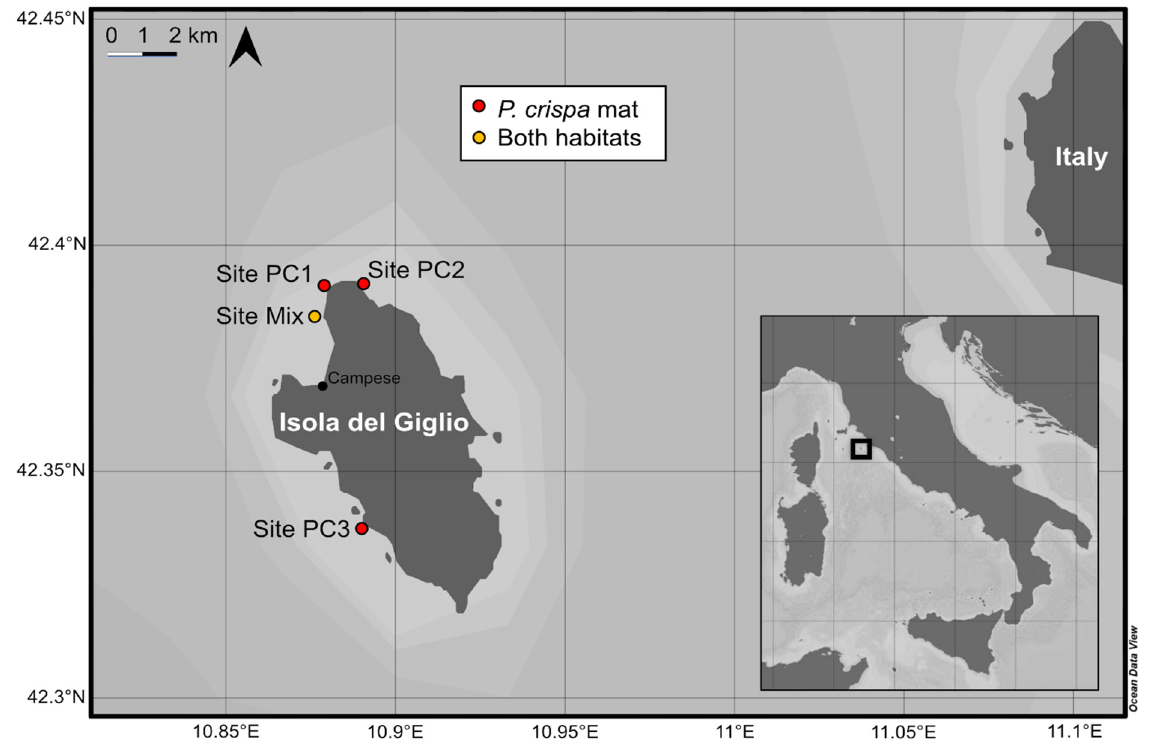
Figure 2. Locations of the sampling sites in the study area (Isola del Giglio, Italy). Red dots mark sampling sites of Phyllophora crispa in 2019, the yellow dot marks the site of comparative sampling in both years (2018 and 2019), and Posidonia oceanica reference habitat (2019).